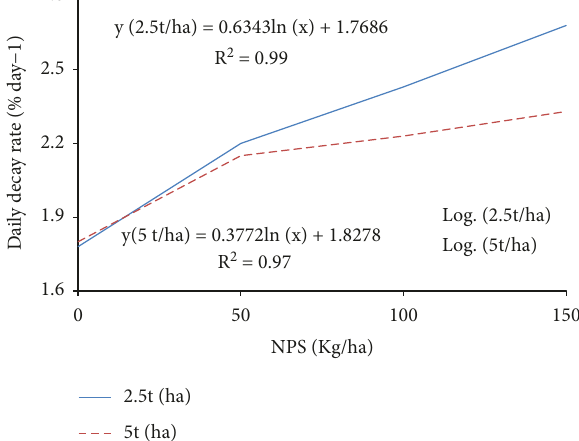
Figure 1: Daily decay rate ( k ) (average of 56 days decomposition) as affected by NPS and LL rates.